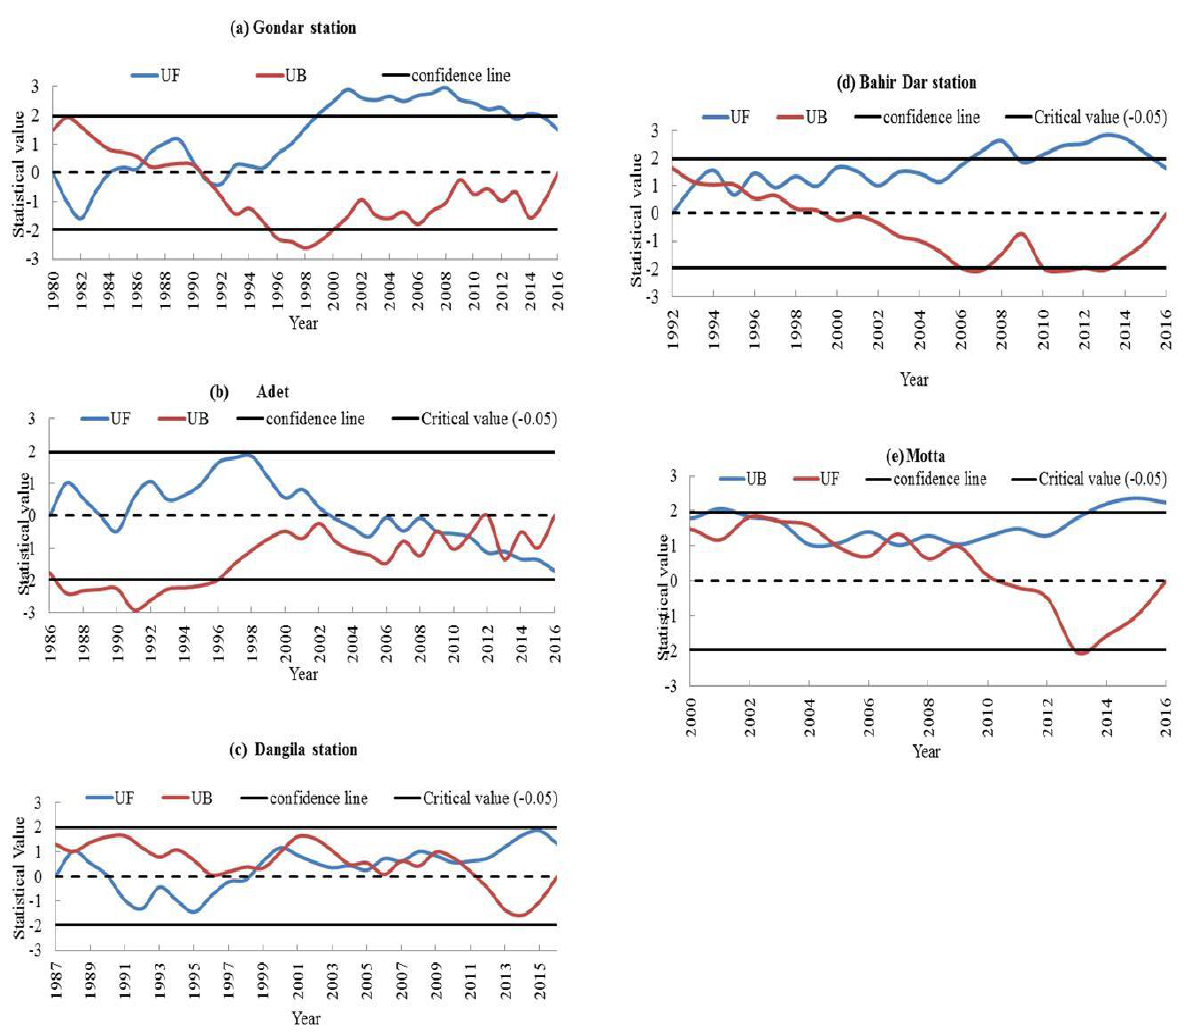
Figure 4. Trends of precipitation in the Nile River Basin.